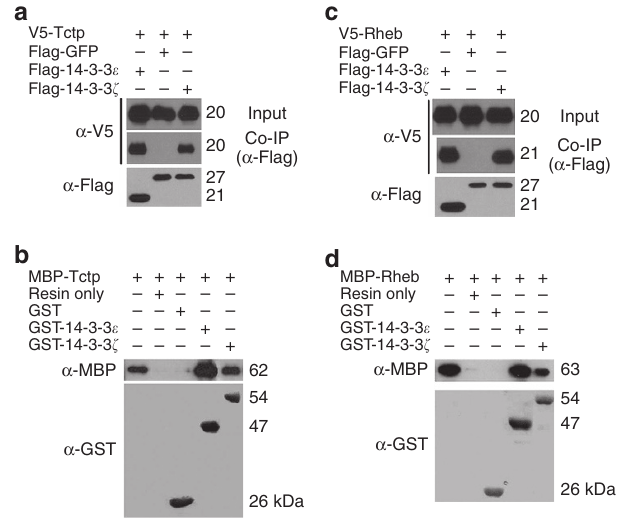
Figure 3 | Effects of Tctp mutation on Rheb and 14-3-3s. ( a – d ) Clones of Tctp h59 null mutant cells in eye disc. ( e – h ) Clones of Tctp h59 null mutant cells in wing disc. These clones are marked by the absence of Arm-lacZ. In both organs, Tctp mutant clones show reduction of Rheb ( c , g ) but not 14-3-3s ( d , h ). Red rectangles in a and e indicate the enlarged regions shown in b – d and f – h respectively. Scale bar, 100 m m ( a – phospho-Histone 3 (PH3; Fig. 5k–m) or activated Caspase 3